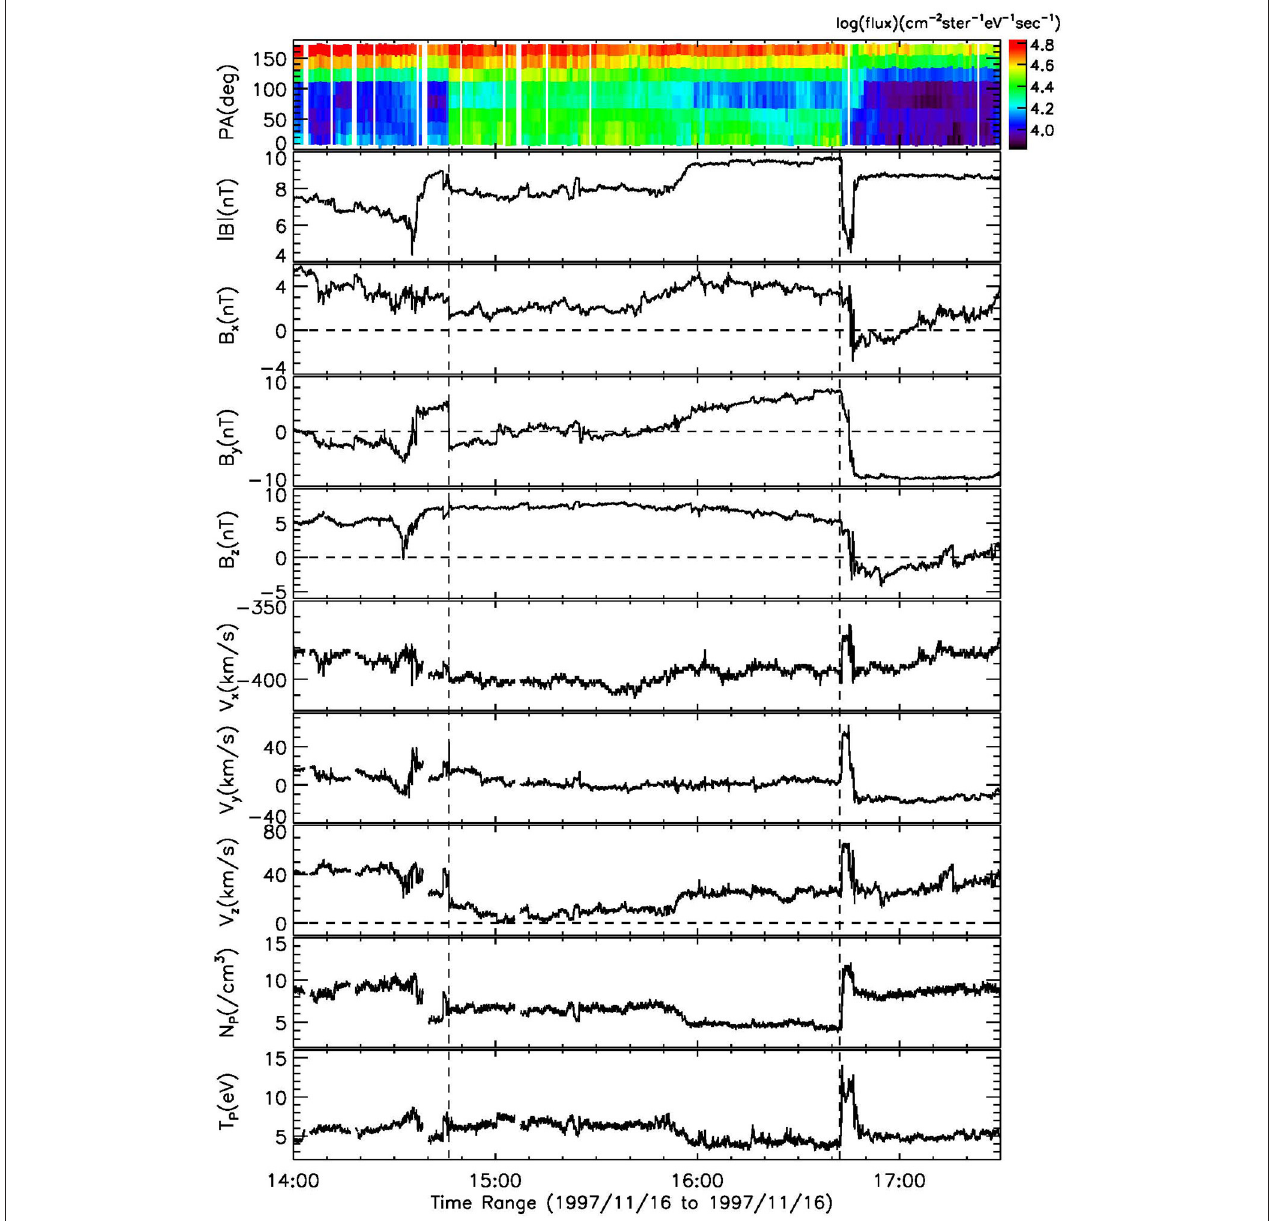
FIGURE 1 | Suprathermal electron pitch angle distributions of 228.17eV, magnetic field, and plasma data measured by Wind during the November 16th, 1997 flux rope passage. The two vertical dashed lines denote the boundaries of the flux rope.